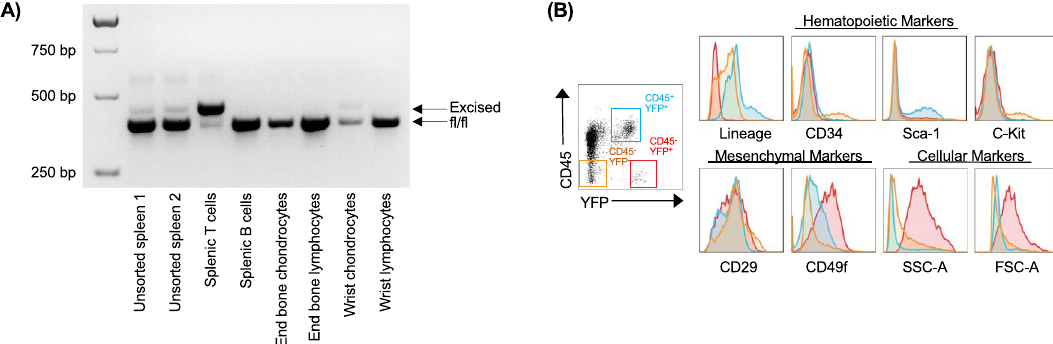
Figure 2. Genetic excision of the floxed region of the Ptpn11 gene in tumor-associated CD45 − YFP + cells, which have a non-hematopoietic, mesenchymal phenotype. ( A ) Cells from SHP-2 KO spleens, end bones, and wrist of two 3–4 week old mice were sorted and pooled. A PCR was performed to examine the excision of the floxed site, where the smaller band represents the non-excised floxed band, and the upper band is the excised floxed band. Lanes from left to right: unsorted splenocytes from mouse 1 and 2, sorted splenic T cells (CD45 + TCRβ + ), sorted splenic B cells (CD45 + CD19 + B220 + ), end bone chondrocytes (CD45 − Lin − ), end bone lymphocytes (CD45 + Lin + ), wrist chondrocytes (CD45 − Lin − ), wrist lymphocytes (CD45 + Lin + ). Data is from cells isolated from SHP-2 KO animals from two independent experiments. ( B ) Representative histograms of hematopoietic markers (lineage cocktail (CD11b, TER119, LY-6C, B220), CD34, Sca-1, C-Kit) and mesenchymal markers (CD29, CD49f), and cellular phenotype by side scatter (SSC-A) and forward scatter (FSC-A). For histograms, CD45 − YFP + cells (red lines), CD45 − YFP − (orange lines), and CD45 + YFP + (blue lines) cells were plotted (n = 6). Data is from cells isolated from 5 to 6-month-old SHP-2 KO animals from two independent